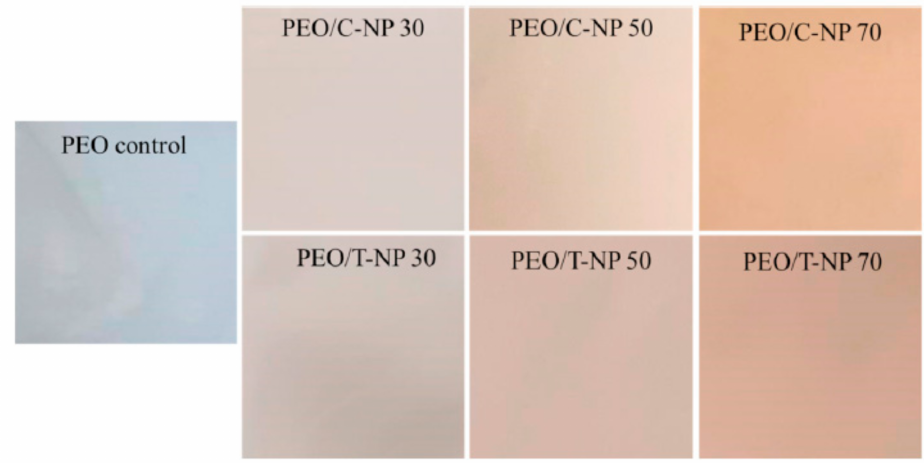
Figure 12. Changes in the appearance and transmittance of polyethylene oxide (PEO) films containing different levels of curcumin-loaded zein nanoparticles. Reprinted with permission from ref. [81]. Copyright 2020 Elsevier